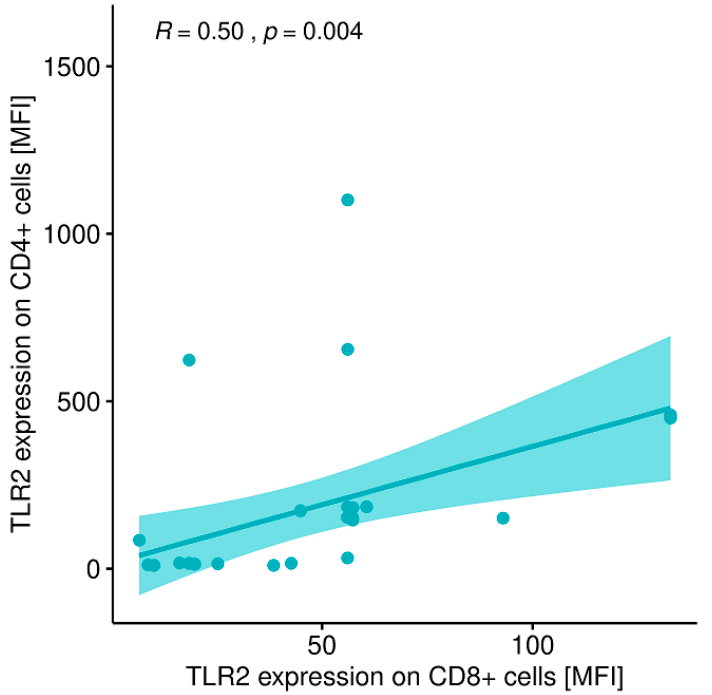
Figure 12. Correlation between the expression of TLR-2 on CD8+ T lymphocytes (MFI) and the expression level of TLR-2 on CD4+ T lymphocytes (MFI) in patients with GD after obtaining euthyroidism. MFI, mean fluorescence intensity.